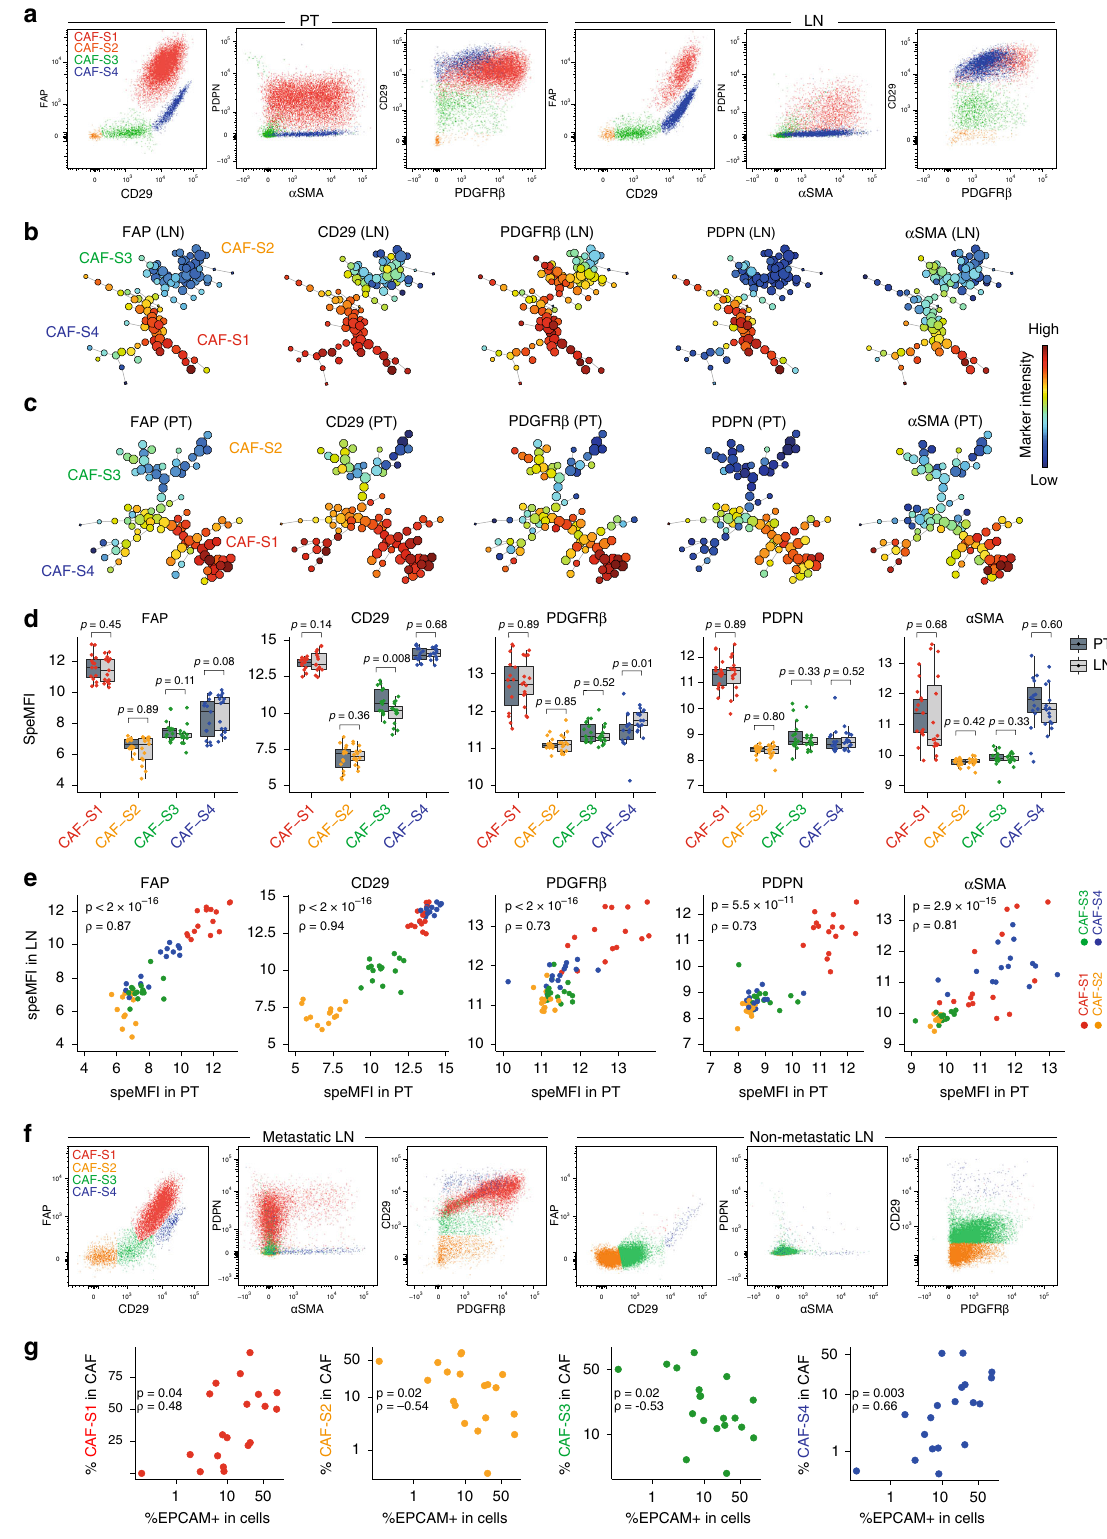
percentage of fi broblasts positive for FAP, SMA and CD29 (re fl ecting CAF-S1 identity) reached 75% of total CAFs in CAF- S1-enriched LNs, and that fi broblasts negative for FAP but positive for SMA and CD29 (re fl ecting CAF-S4 identity) reached 60% of total fi broblasts in CAF-S4-enriched LNs. We also developed an image analysis tool that combined